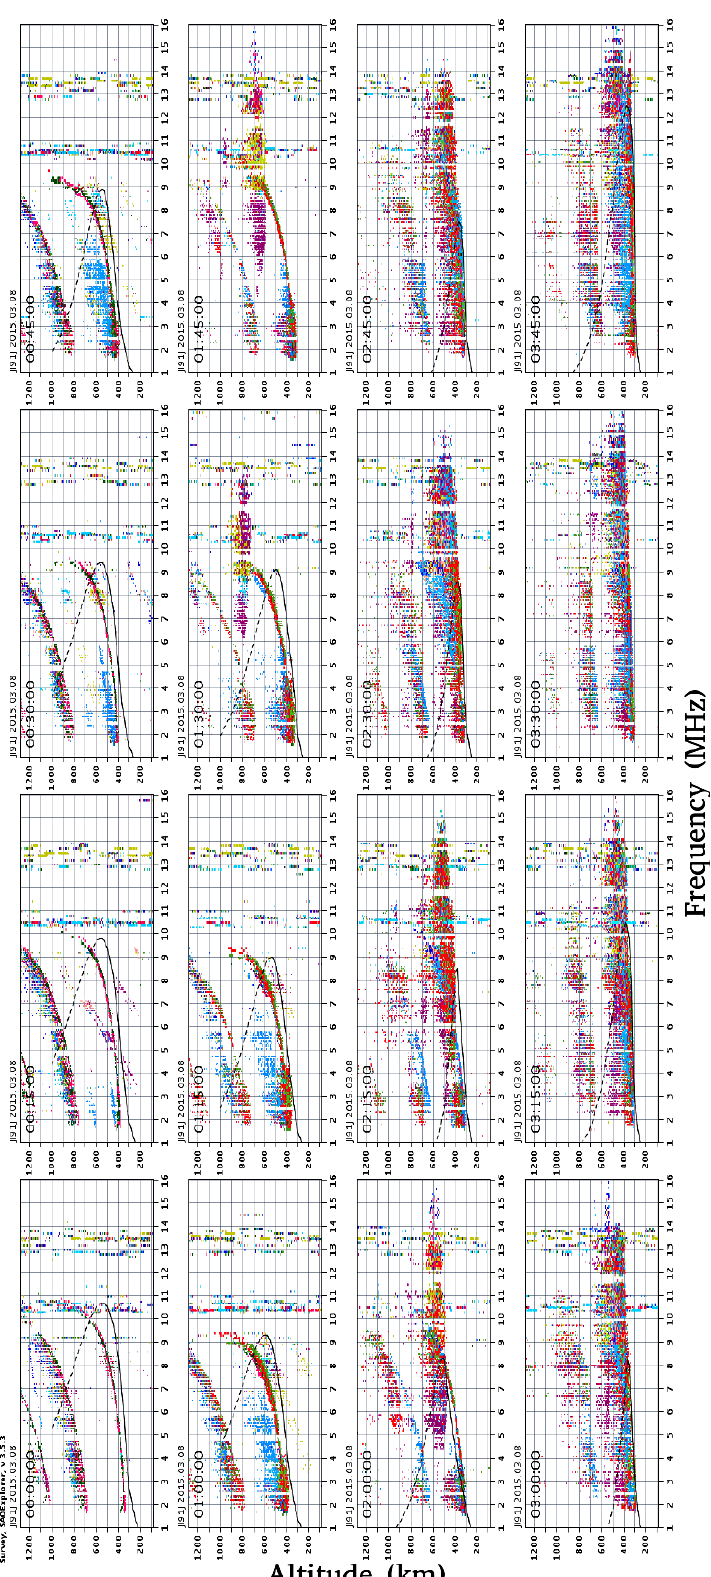
Figure 6. Ionograms showing the occurrence of ESF on 8 March 2015 between 00:15 and 03:45UT. The local time zone of these events was